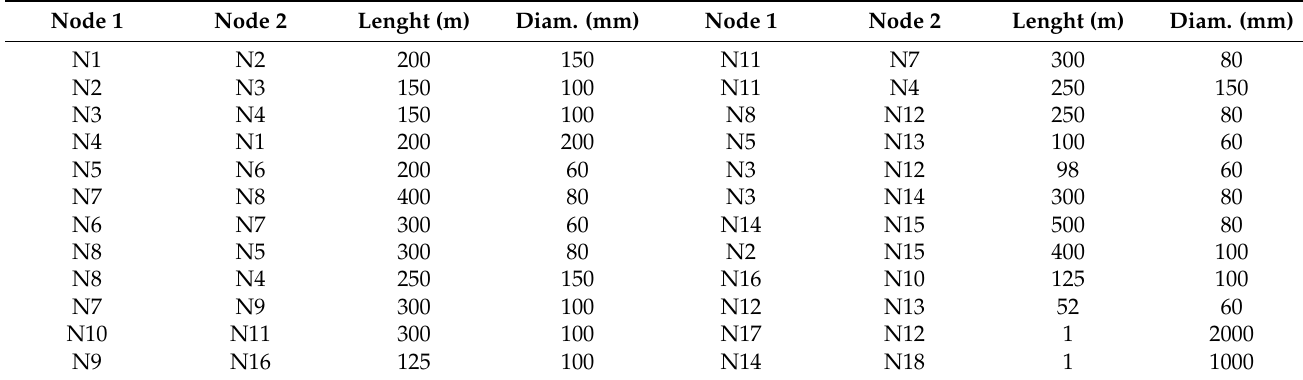
Table 2. Pipes of the TF network.